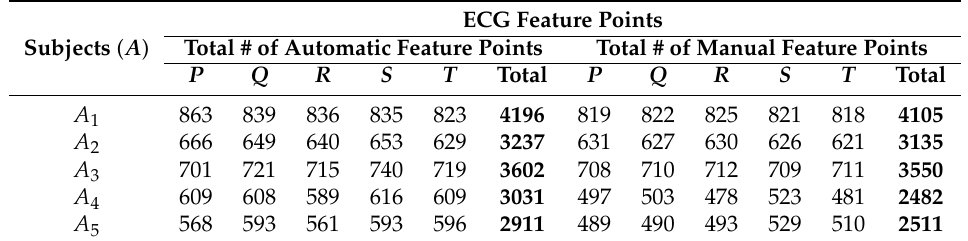
Table 6. Sample result of ECG feature point delineation mechanisms.